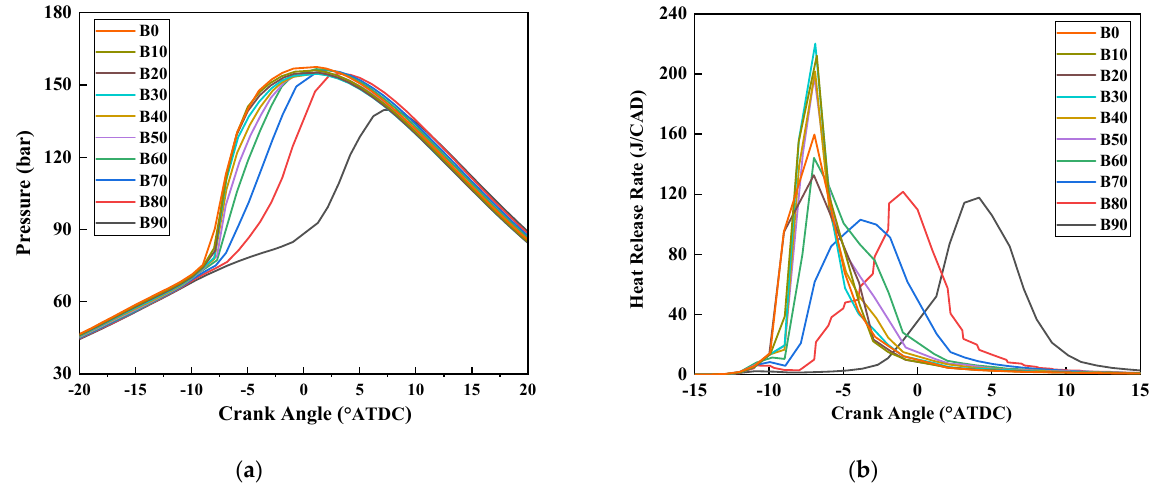
Figure 9. Comparison of in-cylinder pressure and HRR under different n-octanol percentages: ( a ) in-cylinder pressure, ( b ) HRR.